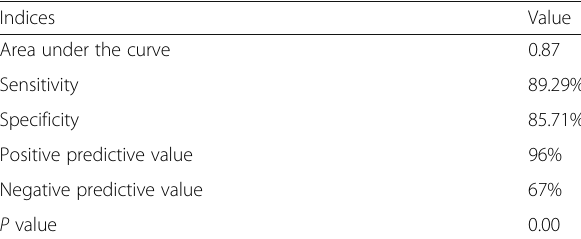
Table 2 Diagnostic accuracy of phase contrast cardiac MRI in diagnosing impaired cardiac function